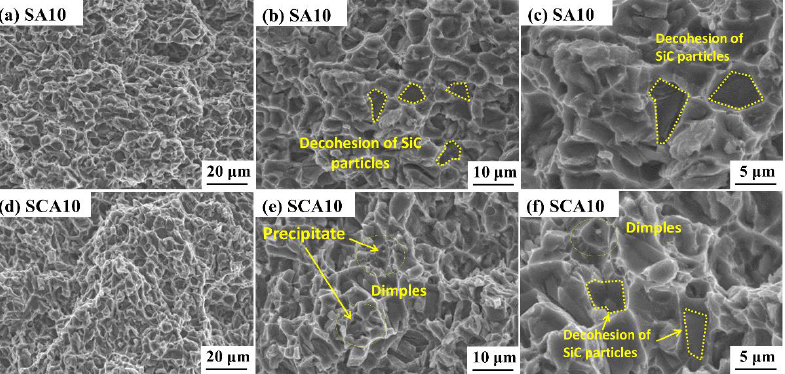
Figure 8. SEM micrographs of tensile fracture surface of samples treated by different processes: ( a – c ) without cryogenic treatment; ( d – f ) with cryogenic treatment.